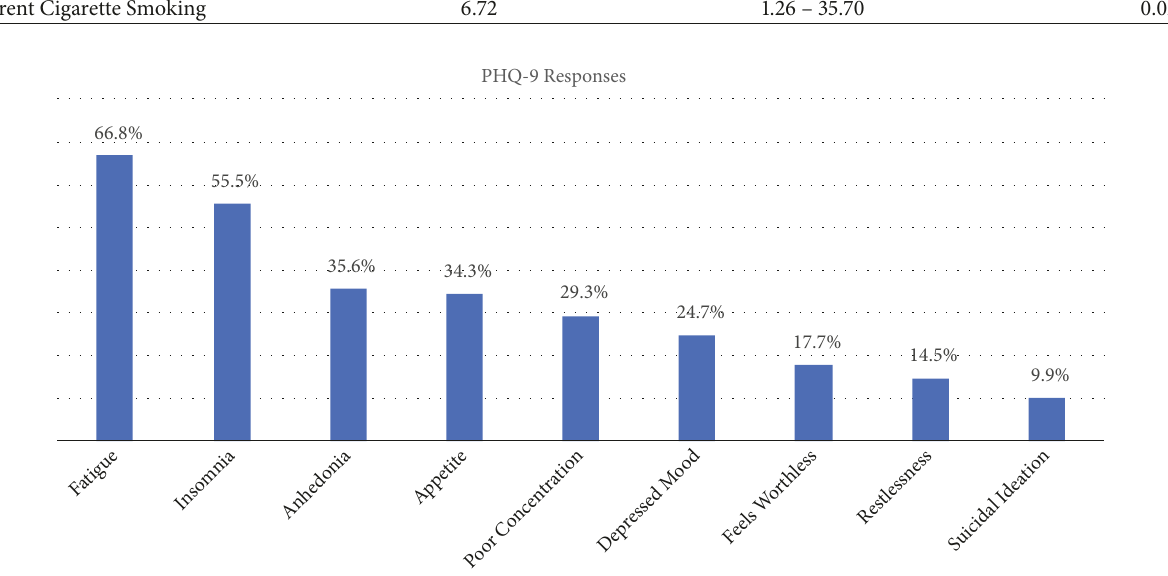
Figure 2: Presenting symptoms among study